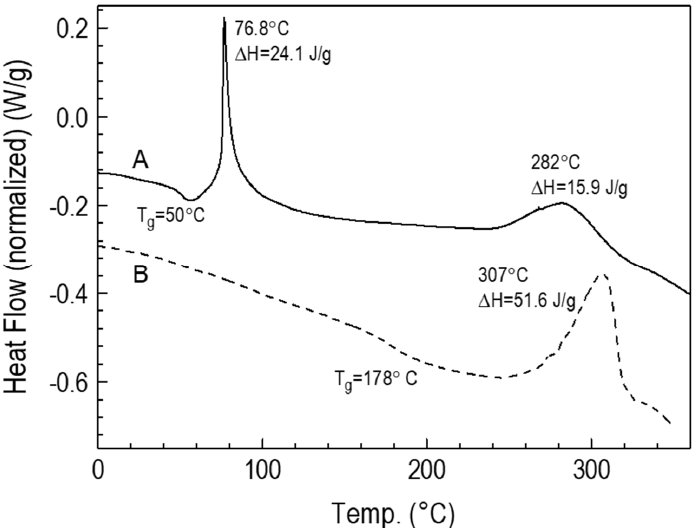
Figure 7. A —DSC curve of thin film #4 after being held 24 h at RT; B —DSC curve of thin film #4 90 min post-bake at 150 °C in air.